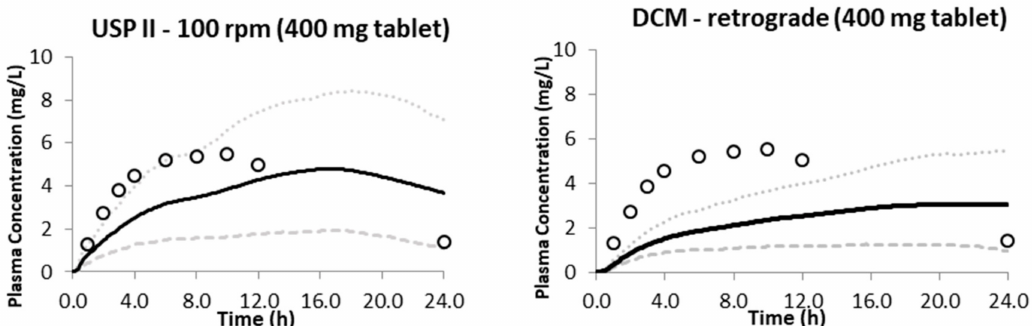
Figure 5. Predicted plasma concentration following oral administration of the Uniphyllin Continus tablet ® (400 mg) single dose (SD) with the dissolution profiles imported from the USP II at 100 rpm and the DCM with the baseline motility pattern [36]. Observed data (open circles); predicted mean (solid); 5th percentile (dashed line); 95% percentile (dotted